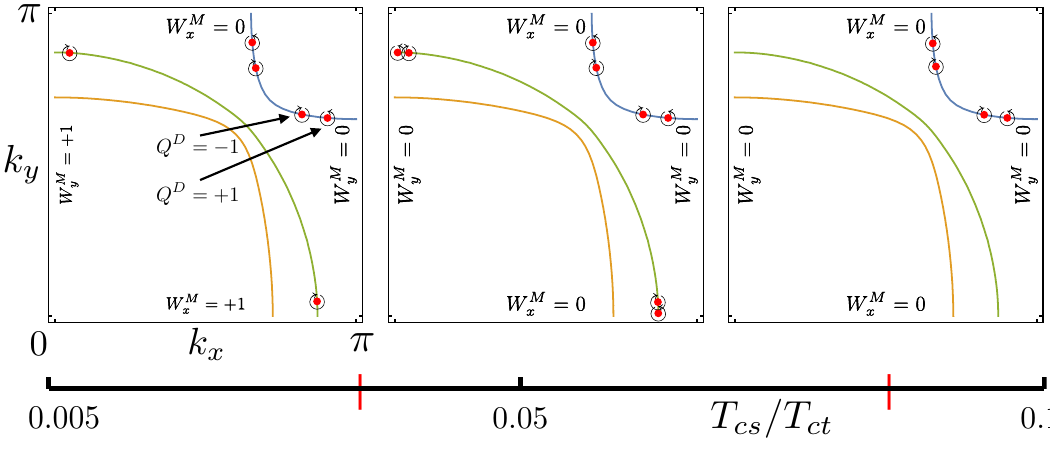
Figure 10: Phase diagram for the two layer system in the presence of intrinsic order param- / T eters in the t -ES as a function of T . The tight-binding parameters are described in cs ct 2 g the text and the tunneling amplitudes are chosen to be A = B = − 0.7, so that in the absence of intrinsic order parameters the system supports semi-Dirac points in α and γ bands. For / T < 0.085 the system supports a Dirac phase, where each semi-Dirac point has 0.035 < T cs ct (cid:28) T splitted into two Dirac points. For T (the leftmost phase) the system supports topolog- cs ct = 1 and W M ,0 = 1. For T / T > ically nontrivial mirror superconductivity with W M ,0 cs ct x y